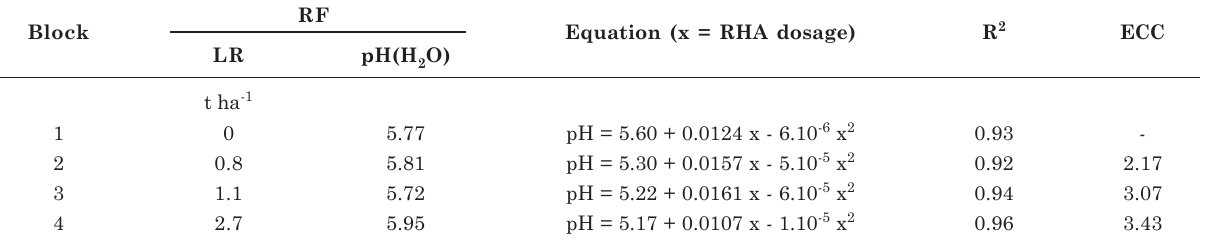
Table 4. Lime requirement with ECC = 100 % (LR) estimated by the SMP method for pH 6.0 and pH (0.00-0.20 m) reached 210 days after liming in the recommended fertilization (RF) treatment plots; equations adjusted to pH response to the applied RHA doses and ECC of RHA estimated from these data in each replication